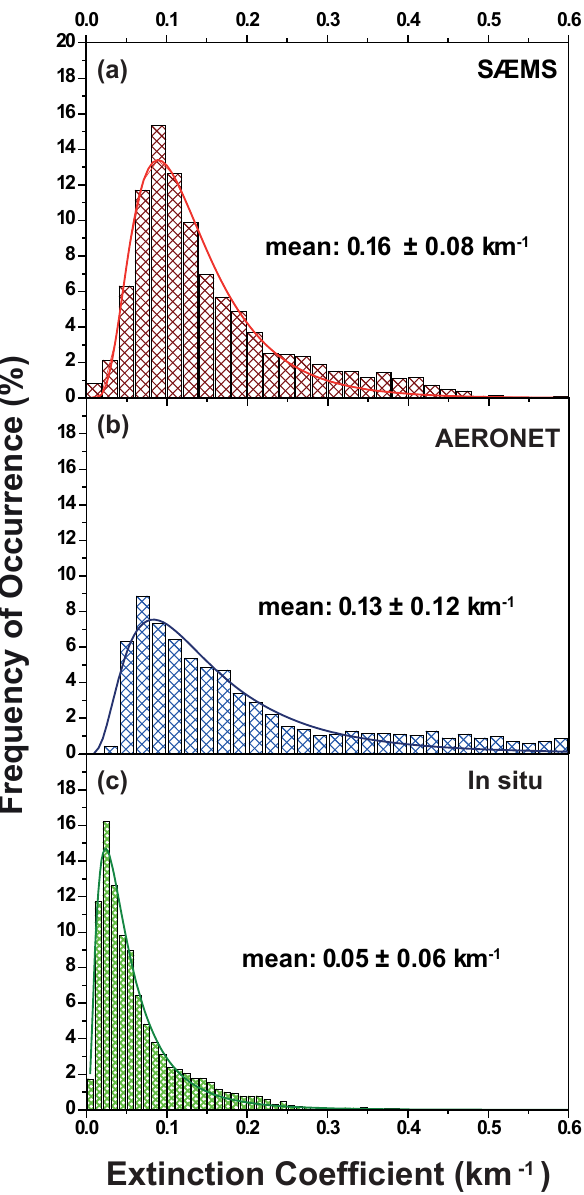
Fig. 11. Frequency distribution of (a) particle extinction coefficients observed with SÆMS at Leipzig in 2009, (b) PBL mean extinction coefficient derived from AERONET observations, and (c) dry parti- cle extinction coefficient, computed from in situ observations of the particle size distribution.